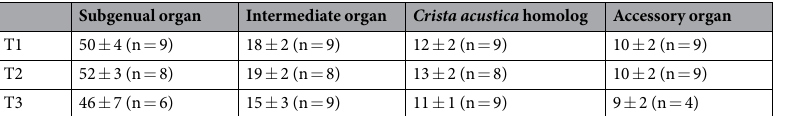
Table 1. Number of scolopidial sensilla in the organs of the complex tibial organ in H. pallitarsis . Abbreviations: T1, foreleg; T2, midleg; T3,